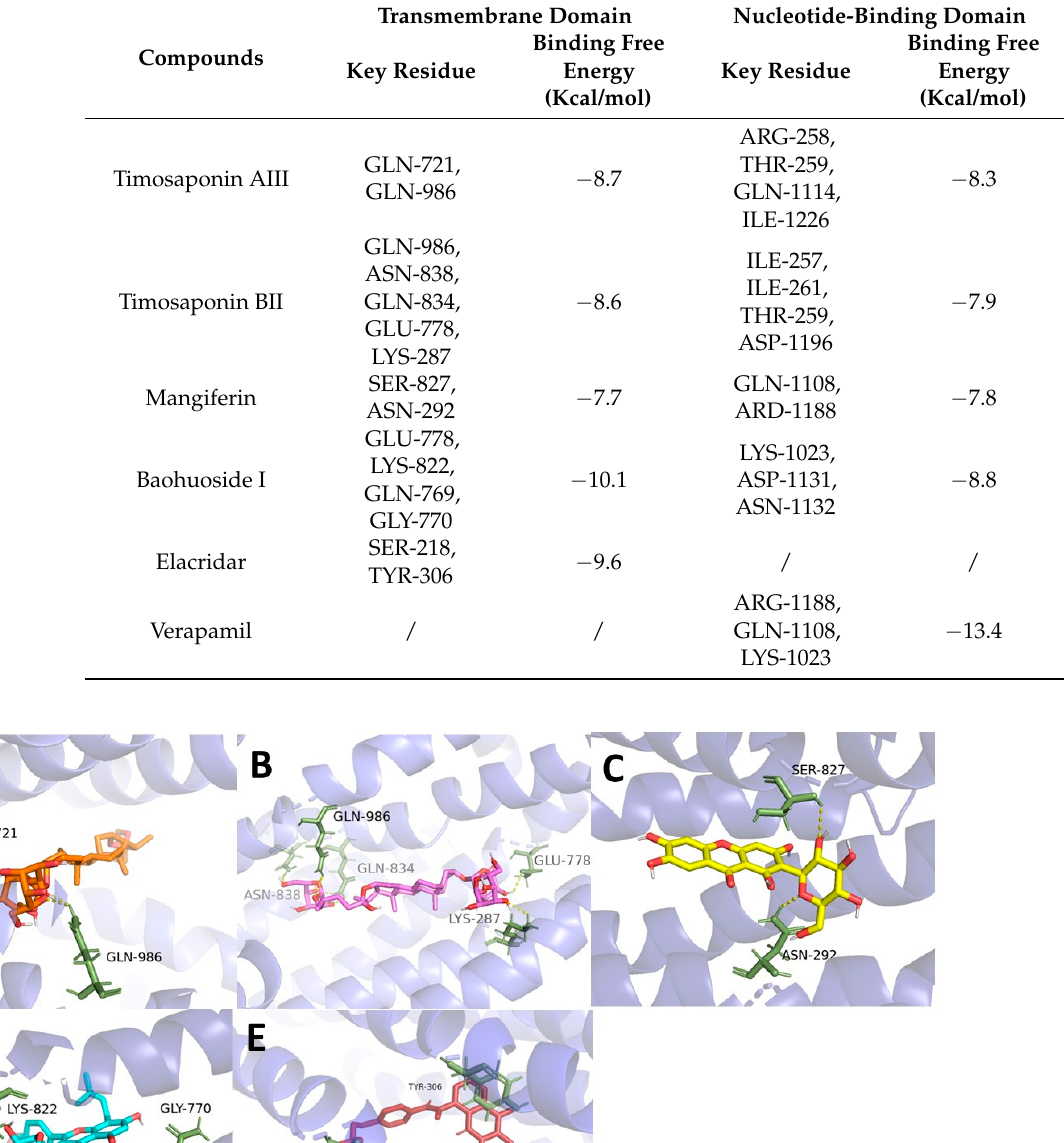
Table 4. Binding free energy and involved key residues for TAIII, TBII, MGF, BHI, elacridar, and verapamil in the predicted binding sites of P-gp.